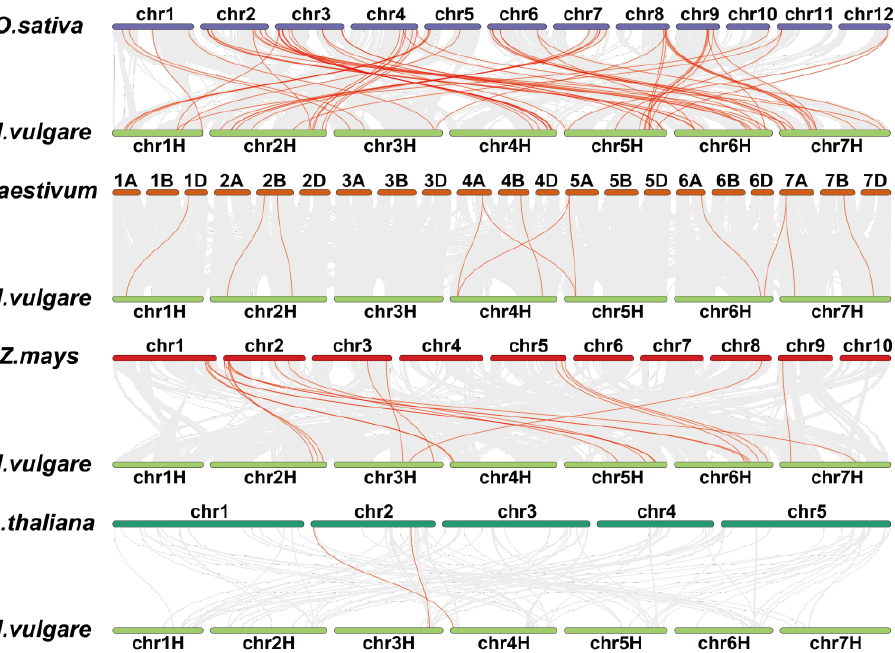
Figure 1. Collinearity analysis between genomes and the grain size genes of barley and other plants. Grain size genes in other plants are shown in Table S1. The grey lines represent the collinearity of genome between H. vulgare and other plants, and the red lines represent the collinearity of the grain size genes between H. vulgare and other plants.